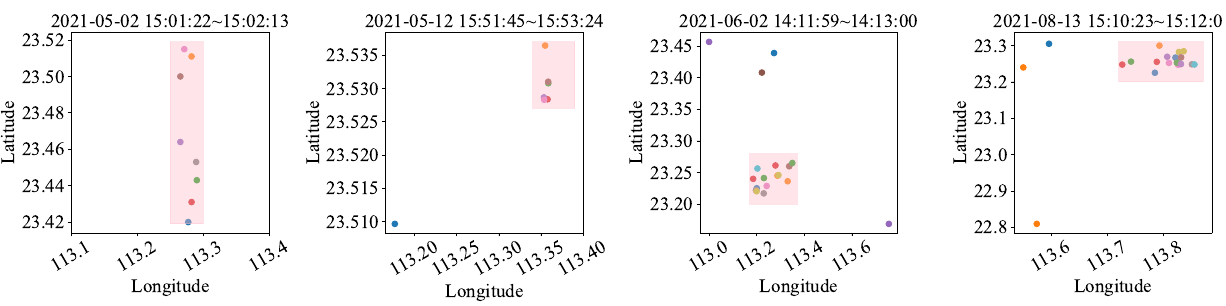
Figure 11. Several thunderstorm samples (the colored dots represent lightning that occurred during the corresponding time period and pink rectangular area represents the lightning’s gathering